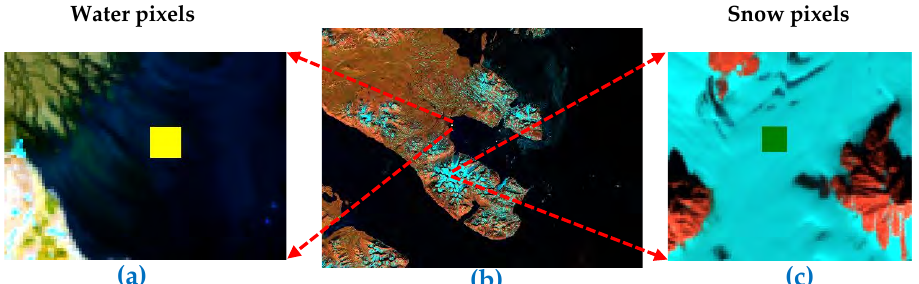
Figure 7. Visualization of the 10 × 10 pixel squares taken in the Greenland region recorded by Landsat 8 OLI: ( a ) sub-region of 10 × 10 water pixels (Yellow square), ( b ) reference color image used to visualize the amount of snow cover in blue color, and ( c ) sub-region of 10 × 10 snow pixels (Green square). These squares are used to compare the capability of the Snow-Cover Indices maps in separating snow from water.